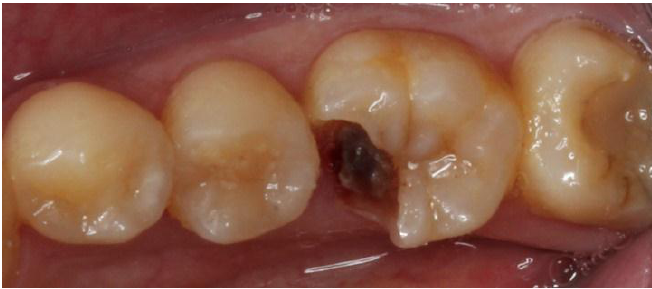
Figure 1. Pre-operative clinical picture of lower right first molar with large cavity over mesial side.